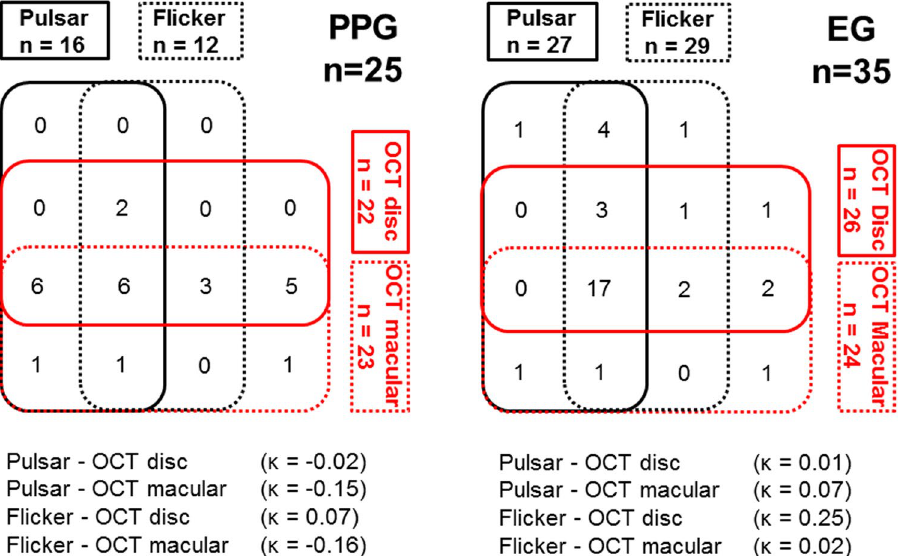
Figure 2. Venn diagram of the eyes detected as abnormality in each device. Abnormality is based on the cut- off value of the best parameter of Pulsar perimetry, Flicker perimetry, optical coherence tomography (OCT) disc measurement, and OCT macular measurement. The agreement values between structural and functional measurements are expressed by kappa coefficients under the Venn diagram.